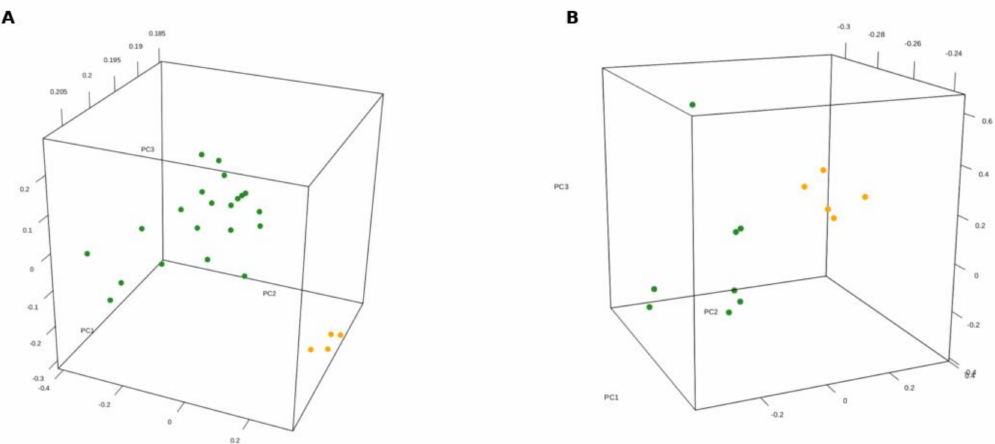
Figure 1. Principal component analysis (PCA) performed on samples analyzed with microarray (( A ) number of SDH- deficient GISTs = 4; number of KIT-mutant GISTs = 21) and RNA-seq (( B ) number SDH-deficient GISTs = 5; number of KIT-mutant GISTs = 8). The unsupervised PCA analysis shows the separation along the second component between the KIT-mutant groups (green points) and the SDH-deficient GISTs (orange